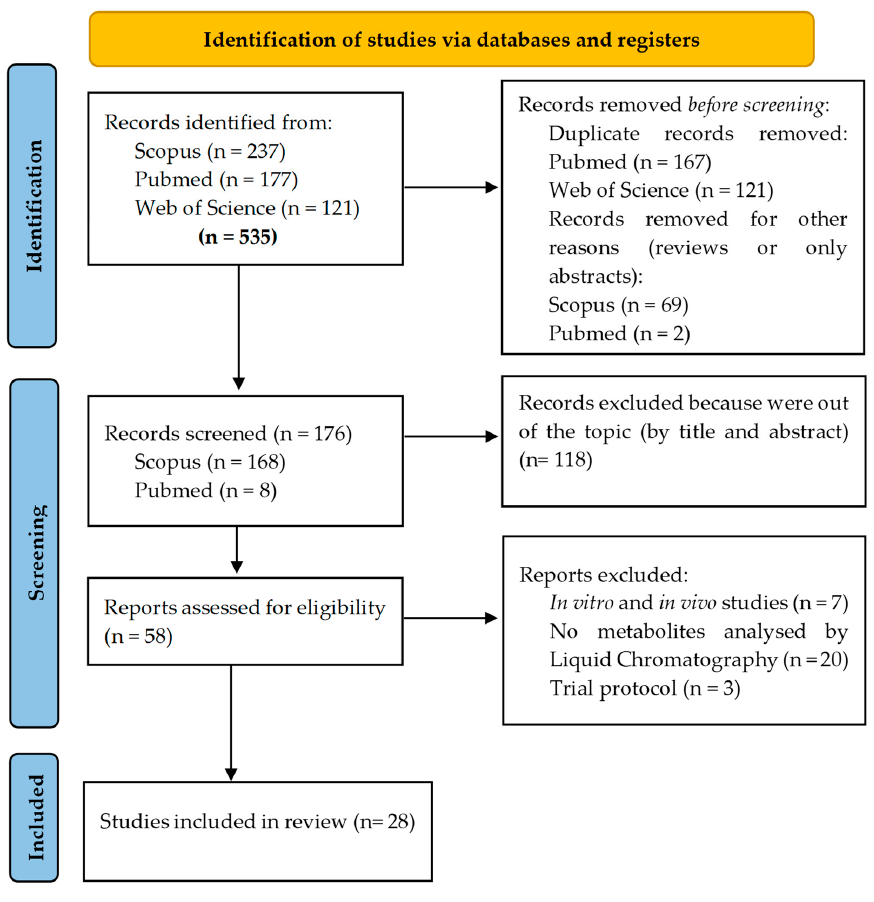
Figure 2. Flowchart of the study selection process.